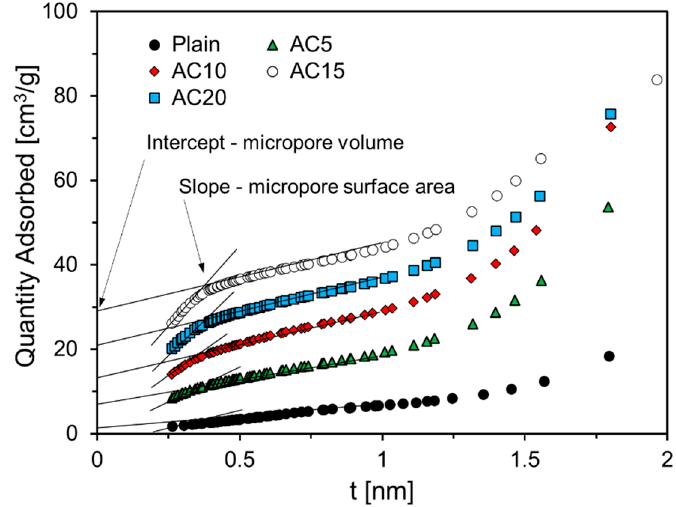
Figure 10. Relationship between quantity and film thickness adsorbed nitrogen of specimens.